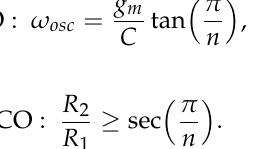
Figure 5. Proposed even-phase MSO with high impedance at current output nodes. 2.4. Non-Ideal Analysis The effect of two non-ideal VDCC properties on the performances of the proposed MSO is studied in this section. These non-ideal cases include parasitic elements and volt- age/current tracking errors. The parasitic elements of the parallel-RC impedance appear- ing at the high impedance input and output terminals are as follows: R P , C P , R N , and C N are at the voltage input P and N terminals, respectively; R Z and C Z are at the current output Z terminal; and R WP , C WP , R WN , and C WN are at the current output W P and W N terminals, respectively. The R X appears in series at the low-impedance X terminal. The β parameter is the voltage tracking error from the Z terminal to the X terminal, and the α parameter is the current tracking error from the X terminal to the W P and W N terminal. The model of the proposed non-ideal lossy integrator circuit with parasitic elements is shown in Figure 6. Figure 6. Model of non-ideal lossy integrator with parasitic elements. The two-pole model [30,36] is employed to investigate the effect of the proposed non- ideal lossy integrator, which can be written in the normal form of the two-pole model as: ( )